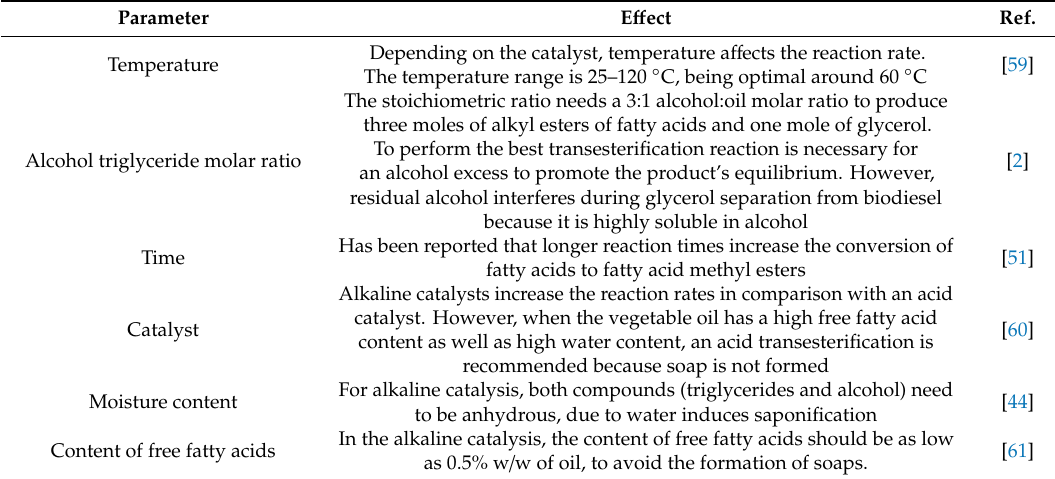
Table 4. E ff ect of main parameters on